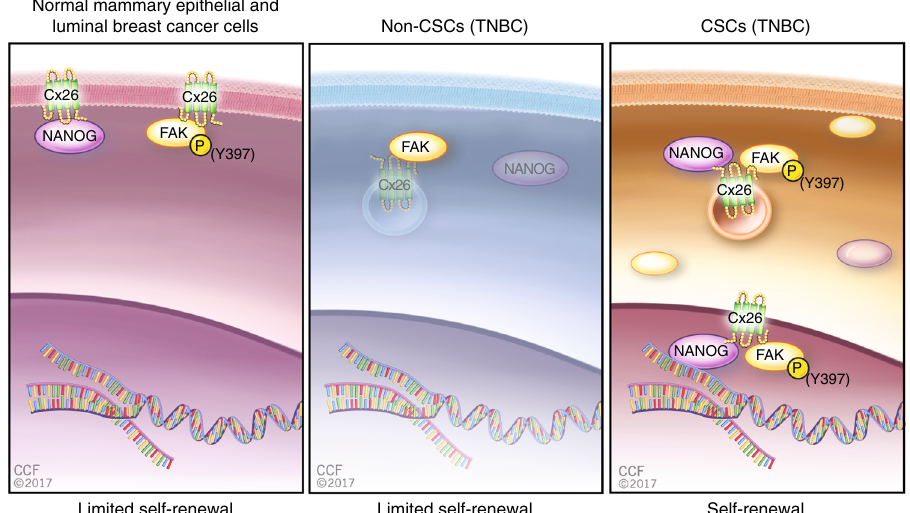
Fig. 7 Model of Cx26, NANOG, and FAK interaction in luminal breast cancer and TNBC cells. Schematic depicting the interaction between Cx26, NANOG, and FAK. In luminal breast cancer cells, Cx26 interacts with FAK and NANOG individually, but the Cx26/NANOG/FAK complex does not form. In TNBC non-CSCs, FAK interacts with Cx26 but is not phosphorylated and NANOG is not present in a complex with Cx26 and FAK. In TNBC CSCs, all three proteins are expressed and form a complex, driving